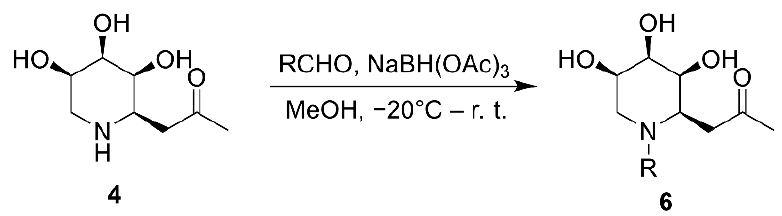
Scheme 3. Synthesis of N ‐ substituted iminosugar C ‐ glycosides.